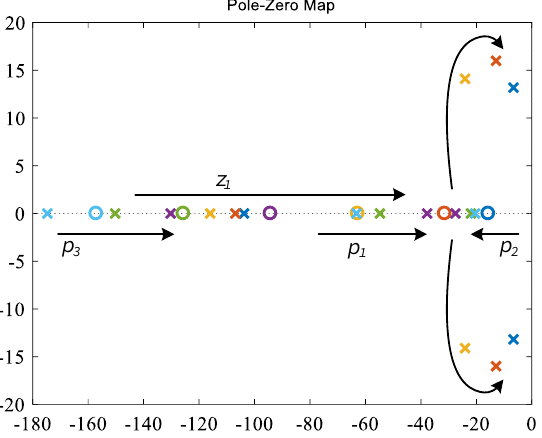
Figure 4. Zero-pole diagram of G r ( s ) with T f varies.